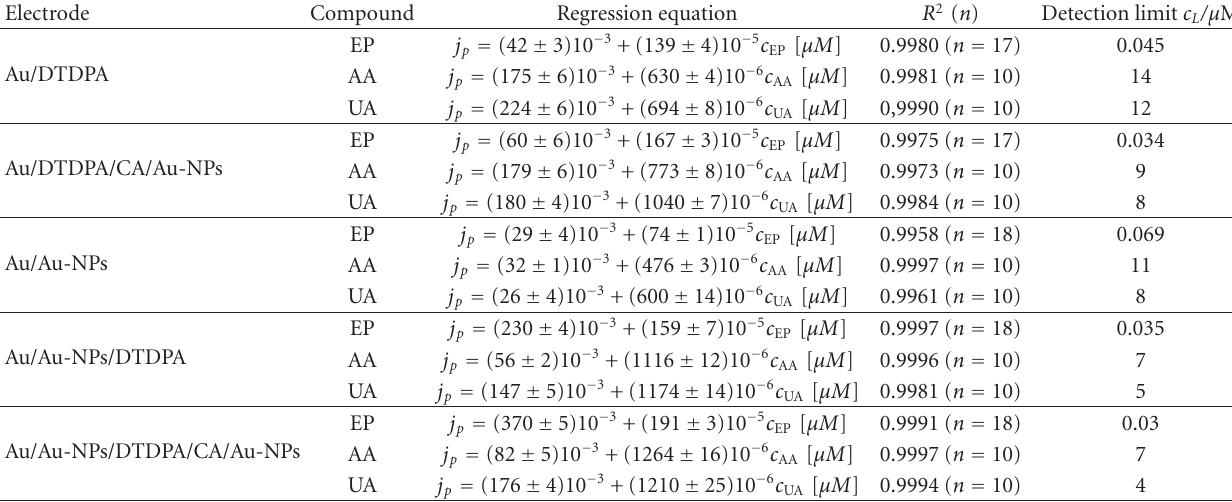
Table 1: Calibration curve parameters for determination of EP, AA and UA on modified gold electrodes. v = 0 . 1 V s − 1